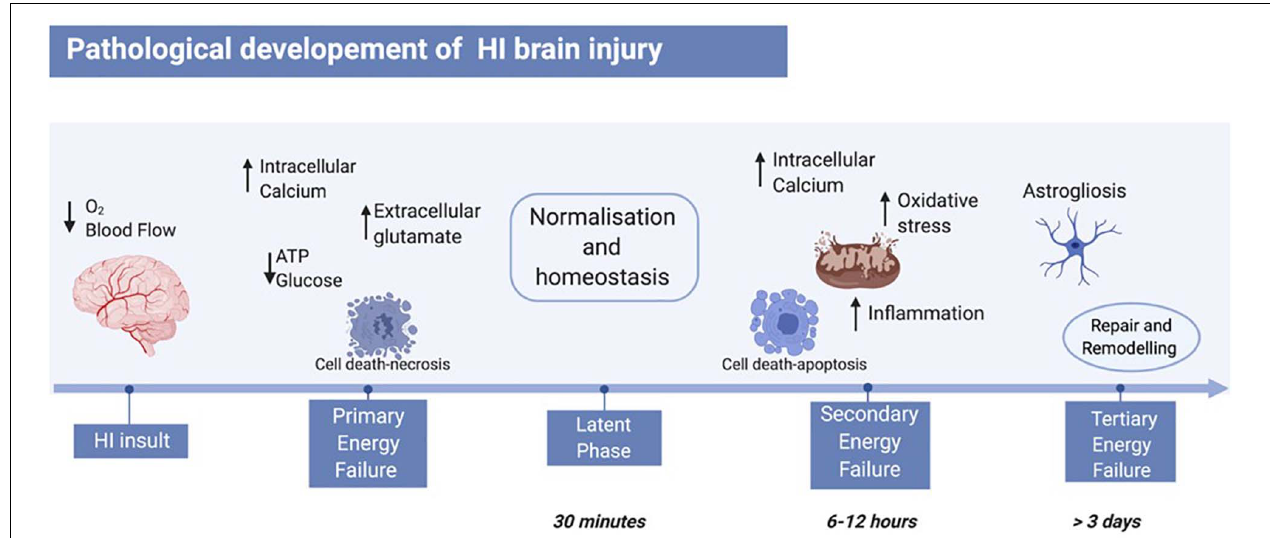
FIGURE 1 | Pathological development of neonatal HI brain injury. The HI insult is initiated by reduction of blood flow and oxygen to the foetal brain, leading to primary energy failure. The main events of this phase include reduction of ATP and glucose, increase of intracellular calcium, and therefore increase of extracellular glutamate. This leads to cell death mainly via necrosis. Following re-oxygenation, a latent phase begins, where the body resumes a “normal” state. A secondary energy failure may take place after 6–12 h post-HI insult, where a subsequent and stronger wave of cell death hits the brain, and events like inflammation, oxidative stress, and mitochondrial damage occur. Depending on the severity of the insult, a tertiary energy failure can occur and persist for months, characterised by brain remodelling and repair, as well as astrogliosis. Figure created with